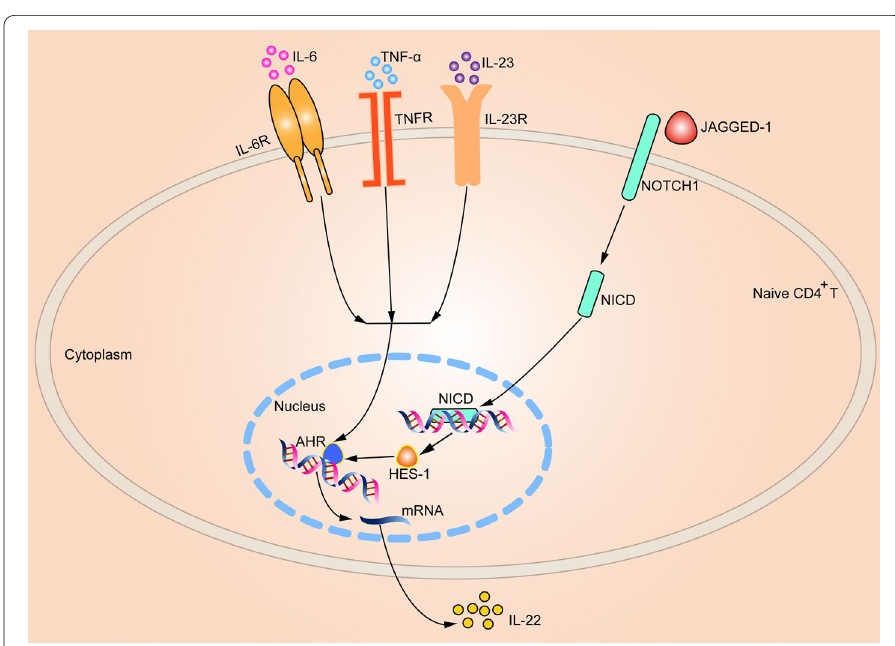
Fig. 5 Schematic diagram illustrating the induction mechanism of Th22 cell differentiation, with involvement of NOTCH